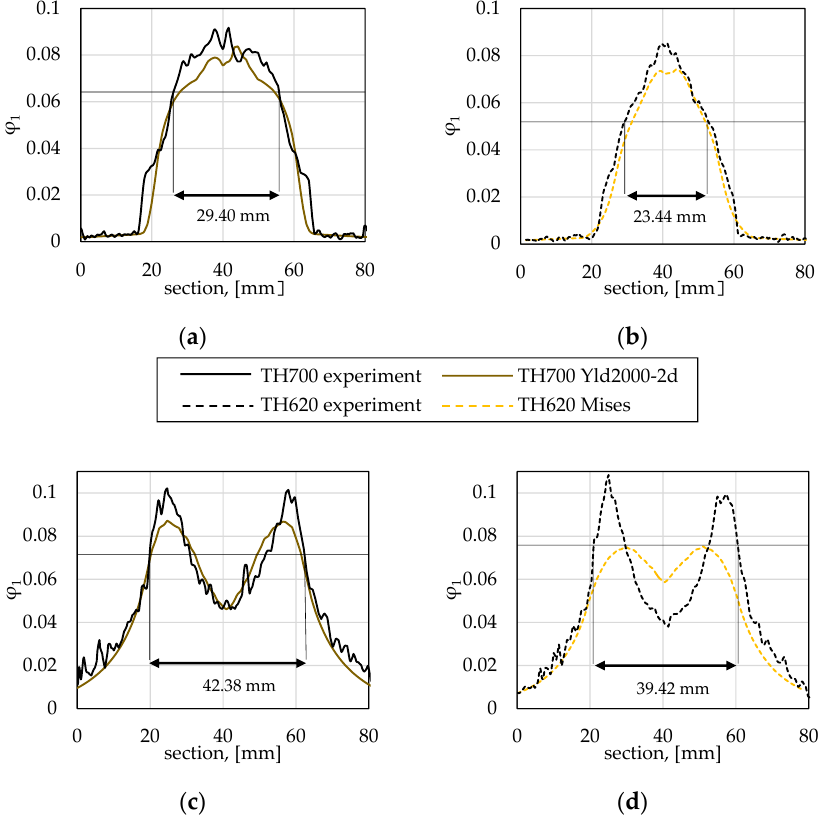
Figure 9. Section (as presented in Figure 5) through Nakajima100 specimen ( a ) TH700 ( b ) TH620 and limited dome height experiment ( c ) TH700 ( d ) TH620.